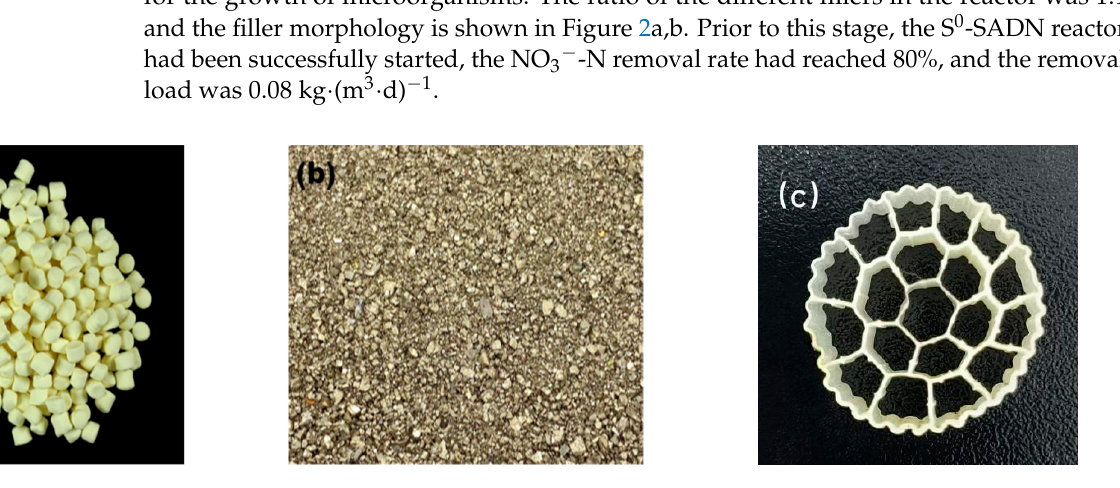
Figure 2. Filler morphological diagram: ( a ) Elemental sulfur particles; ( b ) Pyrite particles; ( c ) Kaldnes filler.